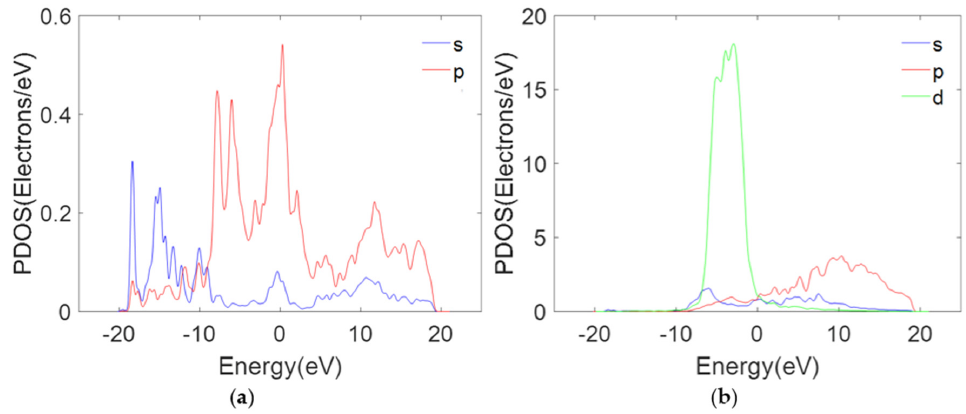
Figure 15. The PDOS for ( a ) the first layer of gold surface, ( b ) the carbon atoms nearest to the gold surface. Fermi energy is set to 0 eV.